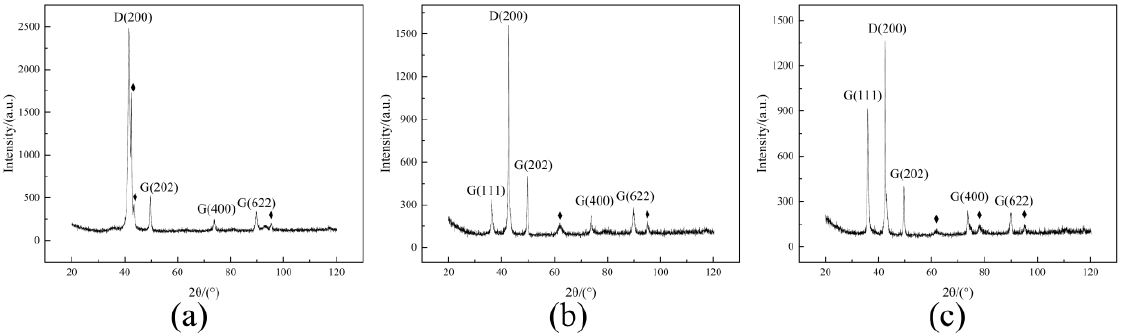
Figure 3. XRD diffraction patterns of Si-DLC with different transition layers: ( a ) AlTiSiN/Si-DLC; ( b ) AlCrN/Si-DLC; ( c ) AlTiCrN/Si-DLC. ( b ) AlCrN/Si-DLC; ( c )